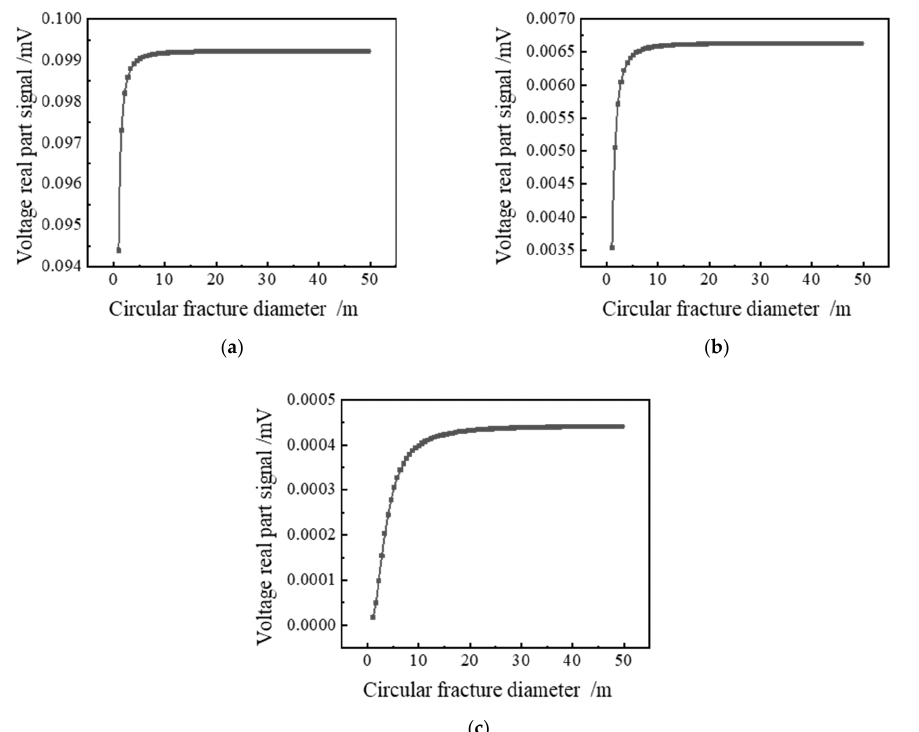
Figure 12. The relationship diagram between the amplitude of the real part of the voltage signal of the three groups’ sub-arrays in origin and the diameter of the circular fracture: ( a ) real part signal of subarray 1; ( b ) real part signal of subarray 4; ( c ) real part signal of subarray 7.